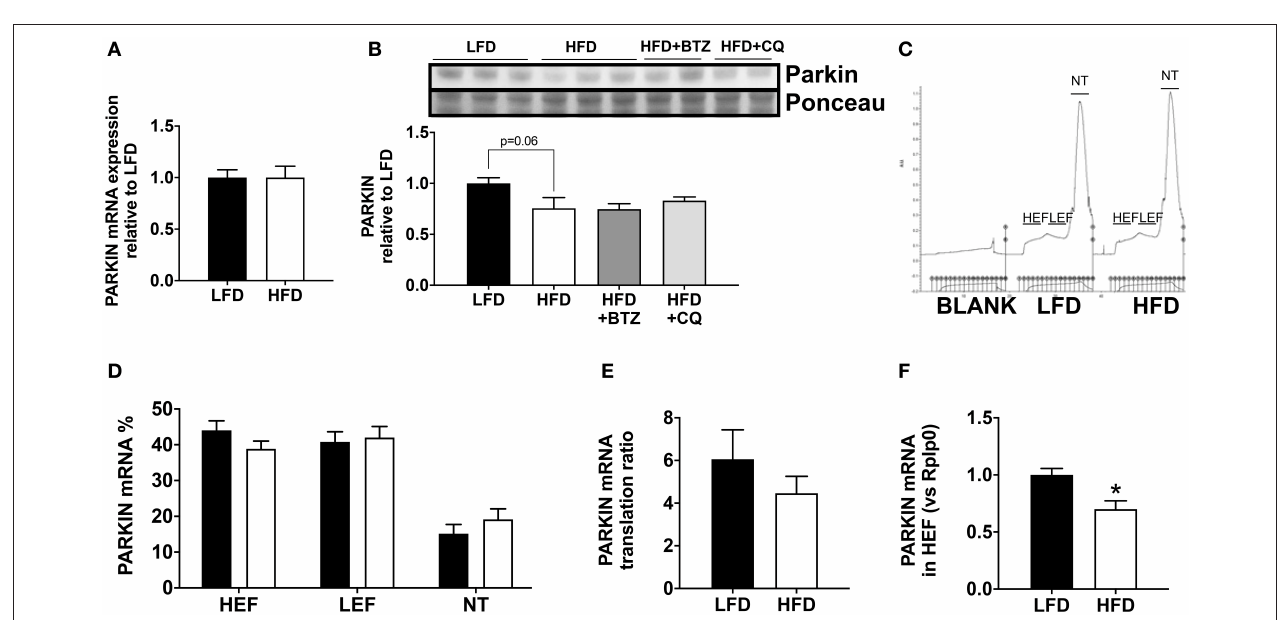
FIGURE 2 | by planimetry (B) , examples of heart slices are shown on the graph. Flow rate recovery was measured at indicated time point after reperfusion (C) . Parkin (D) and ubiquitinated proteins (E) were detected by Western blot in mitochondrial extracts from hearts of LFD and HFD mice after I/R. Cardiac expression of genes